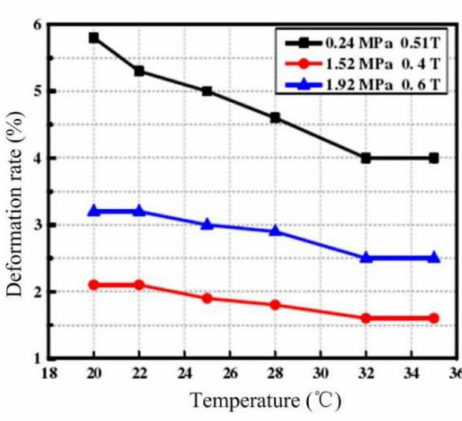
Figure 12. The relationship between deformation rate and temperature.